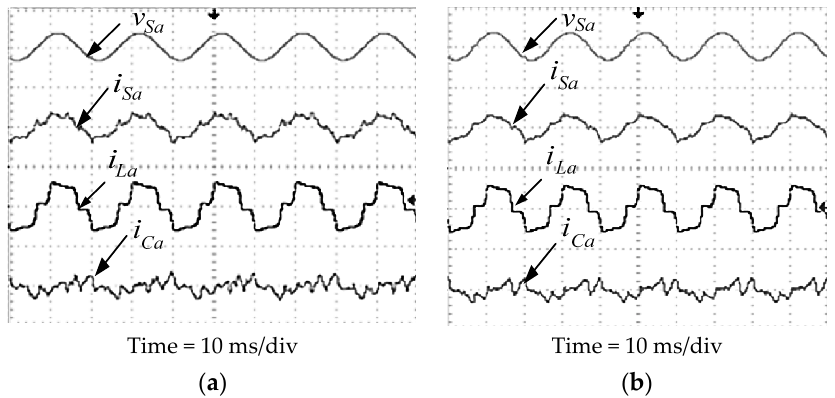
Figure 16. Steady-state experimental result showing the phase a source voltage v Sa (200 V/div), source current i Sa (20 A/div), load current i La (10 A/div), and compensation current i Ca (10 A/div) , resulting from SAPF ( a ) with FLC and ( b ) without FLC.